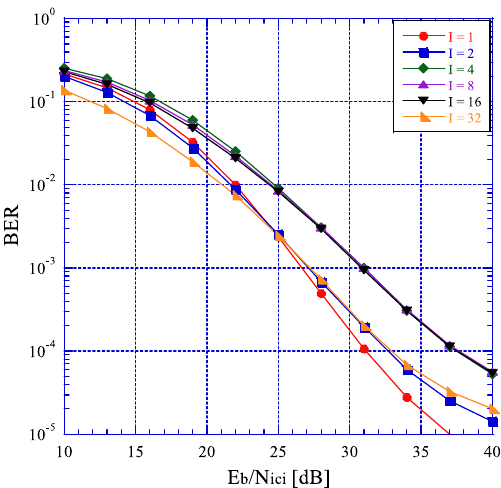
Fig. 14 BER of the various E b / N ici for the interleaved block subcarrier allocation with the DFT and the MMSE, without the coding at E b / N 0 = 25 dB